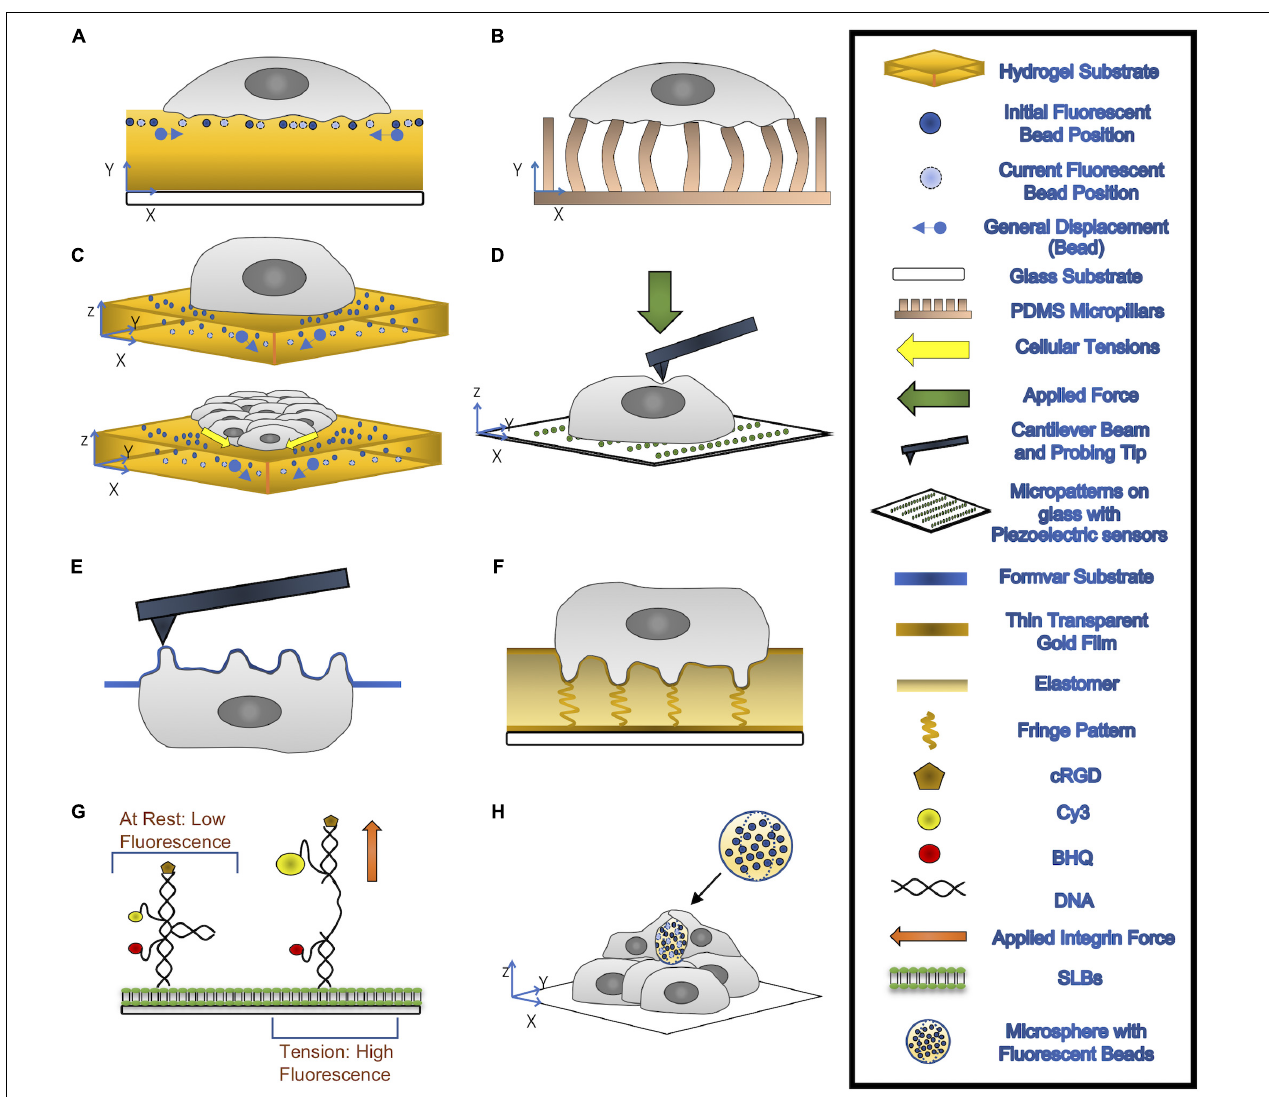
FIGURE 2 | (A,B) 2-D TFM: cells are seeded on top of a hydrogel substrate containing fluorescent beads ( A ) or elastic micropillars (B) . Traction Forces can be measured through the imaging of the beads’ displacements or deflections of micropillars. (C) 3-D TFM (top) and 3-D MSM (bottom): 3-D TFM takes vertical direction displacement into account by comparing 3-D interrogate boxes between the deformed and undeformed state of substrates. 3-D MSM is derived from 3-D TFM and takes bending effects on cellular tensions into account. (D) AFM: A cantilever beam with a probing tip at one end applies a force onto the cell. (E) PFM: cells are seeded onto a formvar substrate, which is then stretched over a mesh grid. This formvar membrane is place upside, allowing for accurate topological information about the podosomes to be recorded through AFM. With the use of mathematical modeling, forces exerted by the podosomes can be calculated. (F) ERISM: thin transparent gold films are placed on top of and below an ultra-soft siloxane-based elastomer. The top gold film is protein coated to allow for cell adhesion. Local deformation caused by the cell to the elastomer form resonance fringes that are captured using established imaging modalities. (G) MT-FILM: surface functionalization of SLB with FRET-based DNA tension probe. When the integrin force applied is greater than F 1 / 2 , the rated force the probe can handle, the linker arms come together and open, causing the florescence of the probe increases. (H) microsphere-based TFM: Microspheres with fluorescent beads embedded are placed within multilayer of cells. After a few days, the cells exert compressive forces that deform the